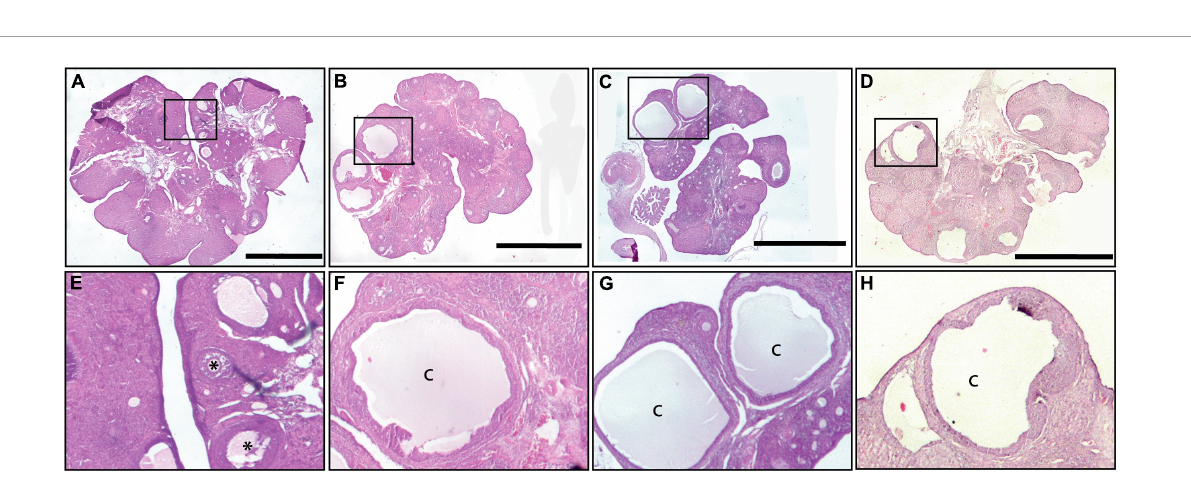
FIGURE5 Ovary morphology. An example of a light–dark (LD) control ovary is shown in (A,E) , of a constant light (LL) ovary in (B,F) , of an ovary from a rat exposed for 3 weeks to LL followed by 12-h restricted feeding as a rescue strategy (LL + RFR) in (C,G) , and of an ovary from a rat exposed to LL simultaneously to RF for 6 weeks as a preventive strategy (LL + RFP) in (D,H) . Asterisks indicate growing follicles, and “c” indicates cysts. Scale bar = 2